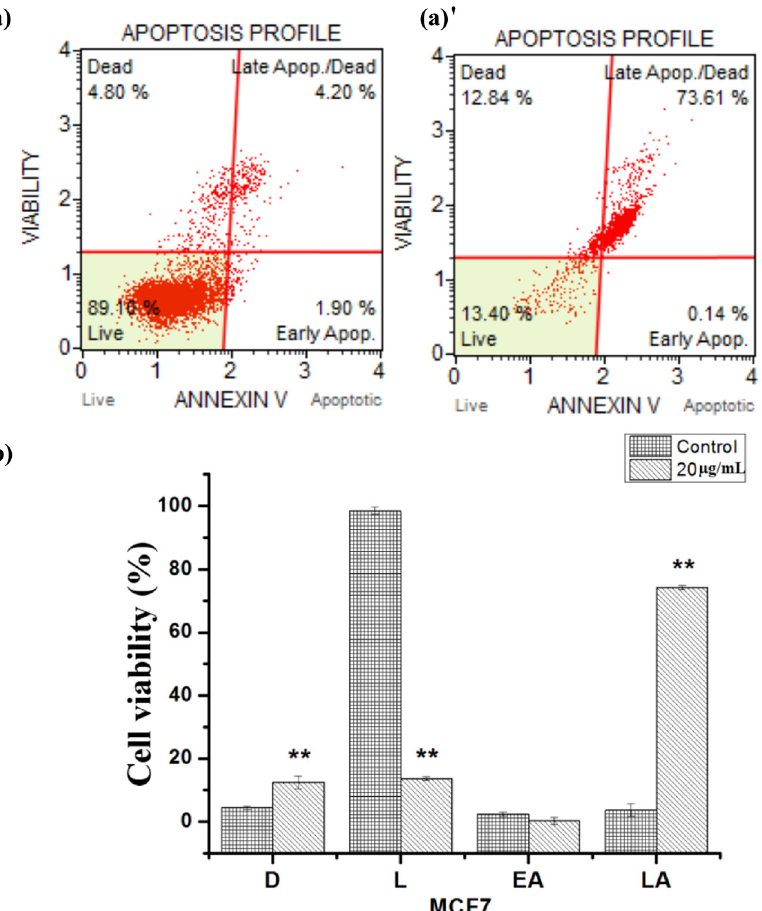
Figure 3: PHF5 - induced apoptosis in MCF7 cells. ( a ) The distribution of the apoptotic cells using the Muse cell analyzer. The cells were incubated with 0.01% MeOH and PHF5 at concentrations of 100 μ g/mL for 48 h. The percentage of early and late apoptotic cells was estimated in comparison with the MeOH control. Each sample was run in triplicate. ( b ) Error bars represent standard deviations. **Signi fi cant di ff erences relative to the control ( P < 0.05 )